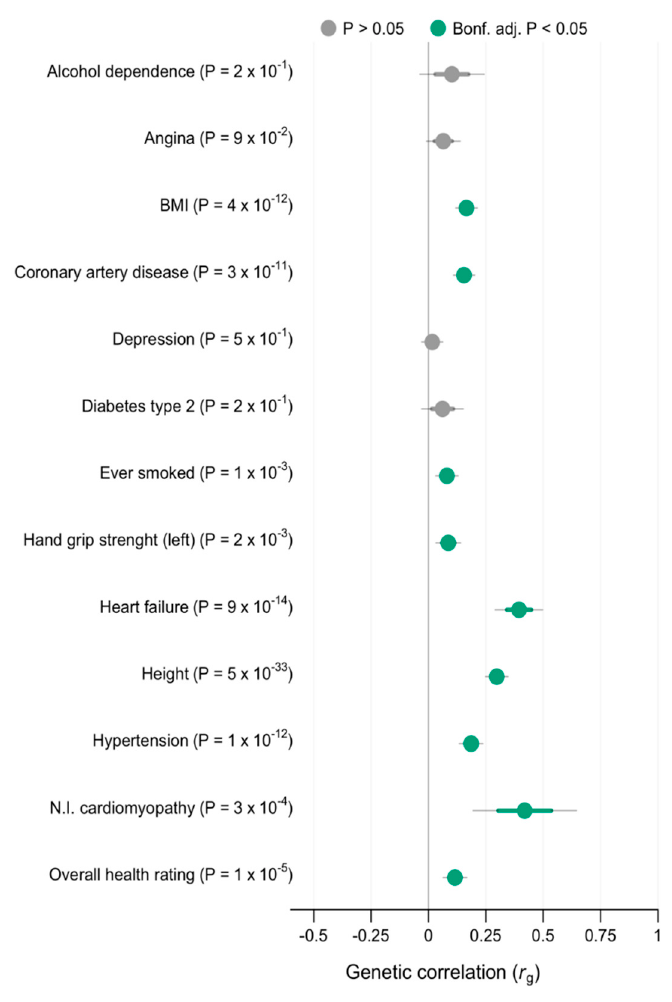
Figure 1. Genetic correlation between AF and 13 other traits with 95% and 99% confidence intervals. Correlations that were significant when accounting for multiple testing are marked in green. Bonf. adj., Bonferroni adjusted; BMI, body mass index; N.I. cardiomyopathy, non-ischemic cardiomyopathy.